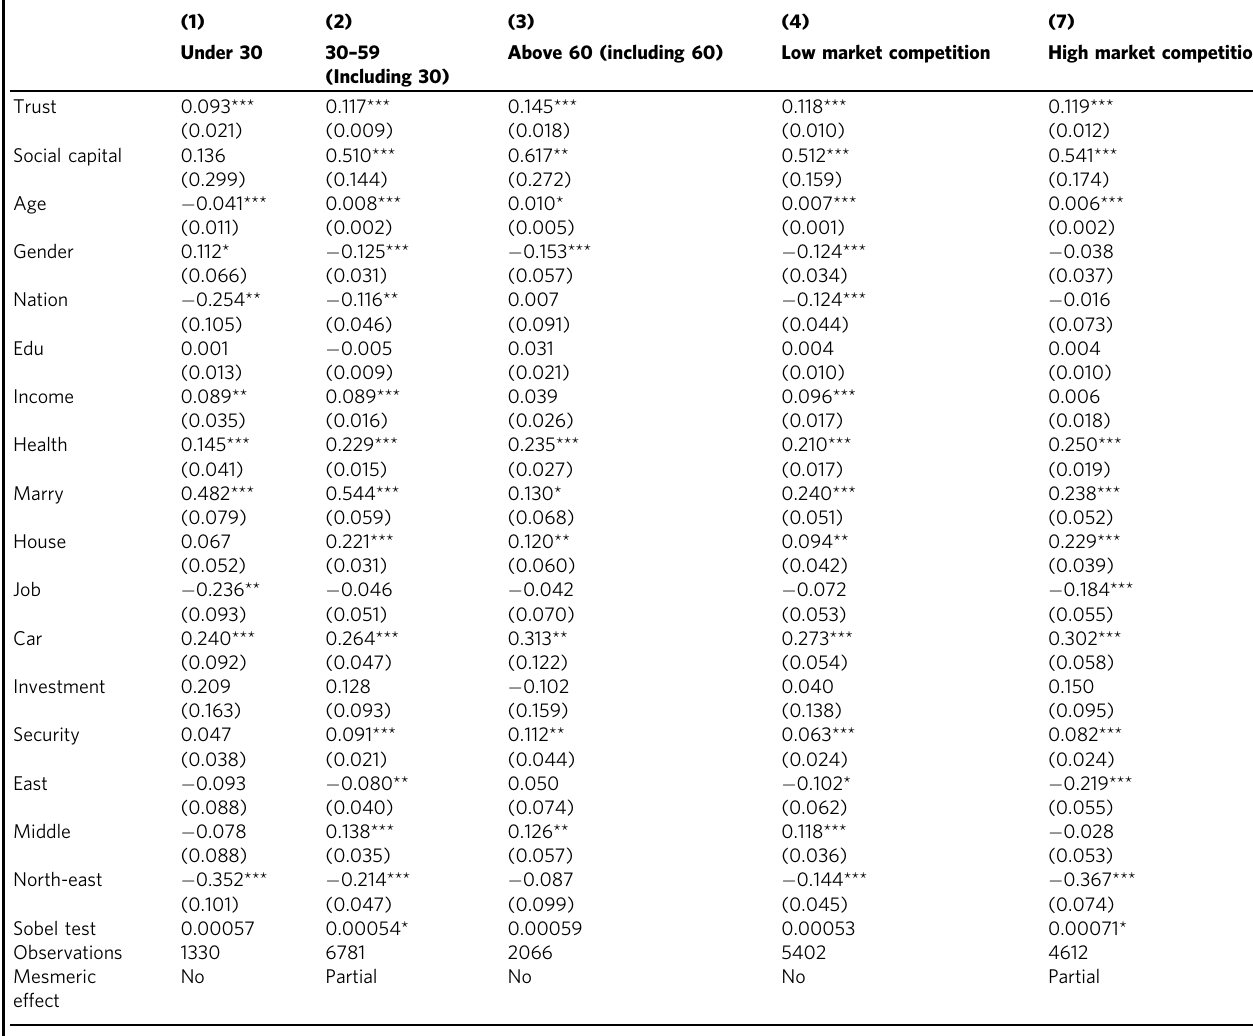
Table 5 Group test on happiness by trust and social